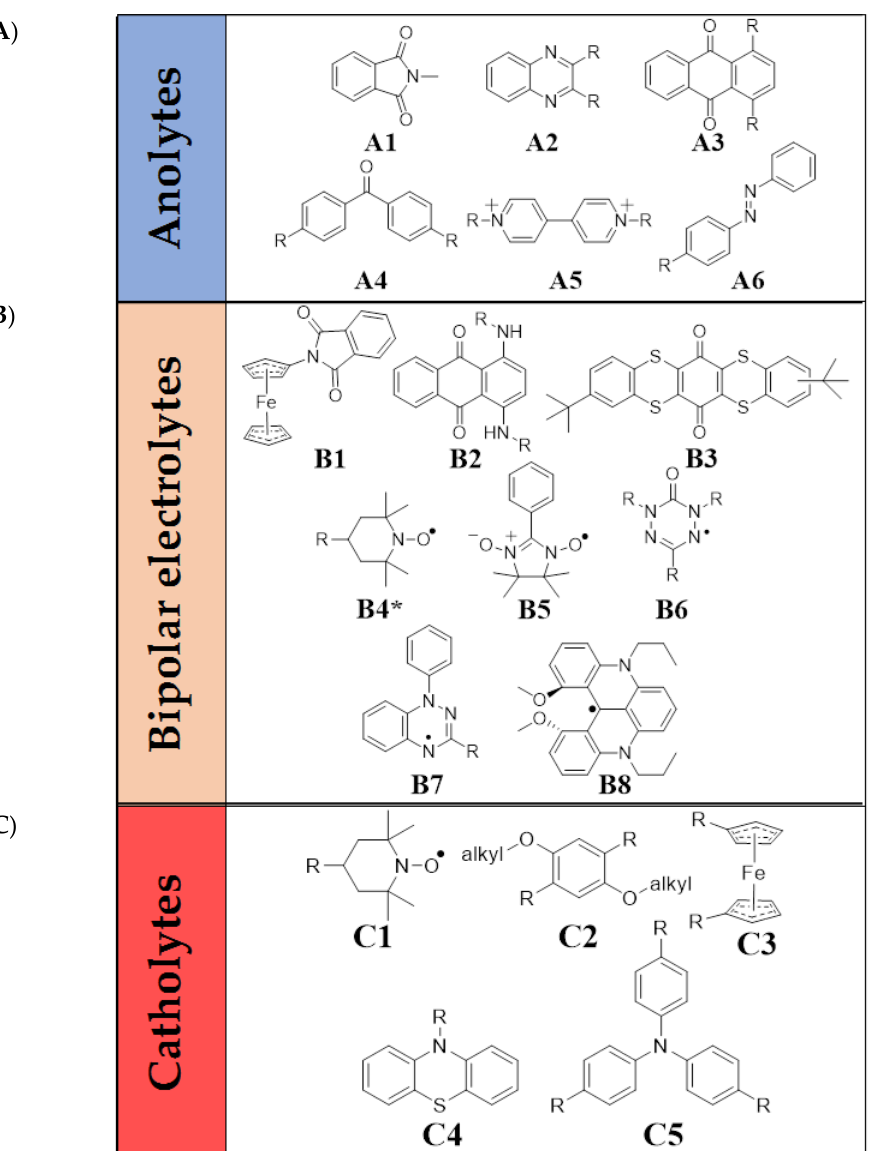
Figure 8. Pivotal chemical structures in the domain of organic ( A ) anolytes, ( B ) bipolar electrolytes, and ( C ) catholytes. We note that through its widespread use in organics, and its similarity thereto, ferrocene has been included as an exception. A1 = N -methylphthalimide [96,97], A2 = quinoxaline [98], A3 = anthraquinone [99], A4 = benzophenone [100], A5 = viologen [101,102], A6 = azobenzene [103,104]. B1 = N -ferrocenylphthalimide [105], B2 = 1,4-diaminoanthraquinone [106,107], B3 = thianthrene [108], B4 * = 2,2,6,6-tetramethyl-1-piperidinyloxy (TEMPO) in ionic liquid [109], B5 = 2-phenyl-4,4,5,5-tetramethylimidazoline-1-oxyl-3-oxide [110,111], B6 = 1,5-diphenyl-3-isopropyl-6-oxo-